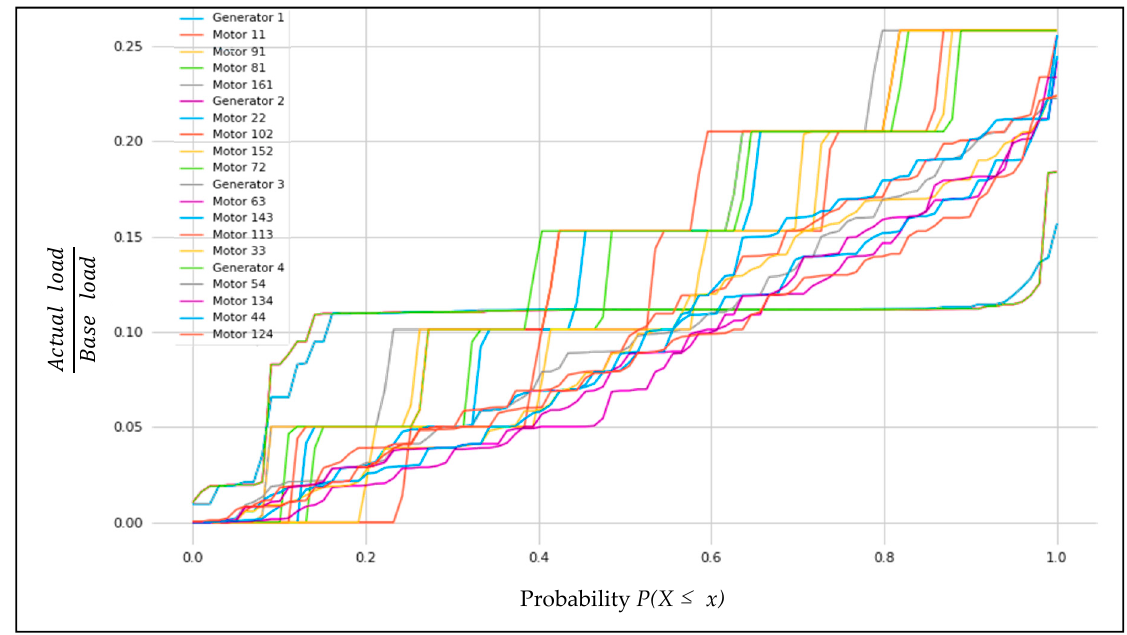
Figure 31. LH cruising branch load probability.